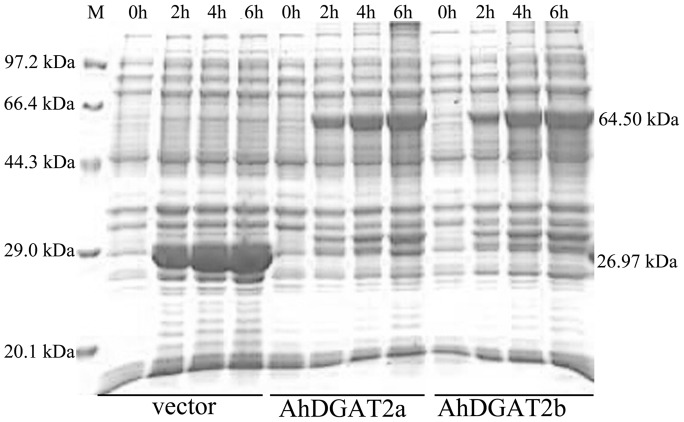
SDS–PAGE analysis of the time course for expression of AhDGAT2a and AhDGAT2b recombinant fusion proteins in E. coli cell extracts.Recombinant proteins transformed into E. coli were induced with IPTG and their expression levels evaluated after 0, 2, 4, and 6 h. Molecular weight standards are shown on the left. The relative mobilities of GST (26.97 kDa), AhDGAT2a–GST (64.5 kDa), and AhDGAT2b–GST fusion proteins (64.5 kDa) are indicated on the right.